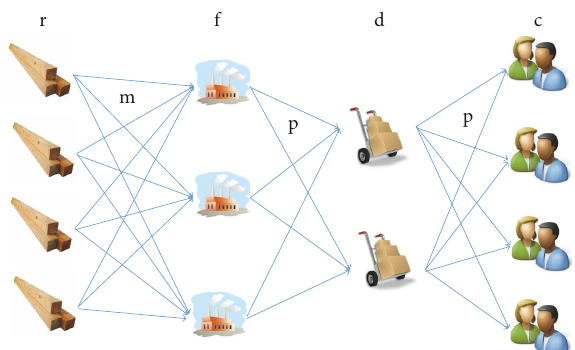
Figure 1: Structure of the analyzed supply chain (source: own